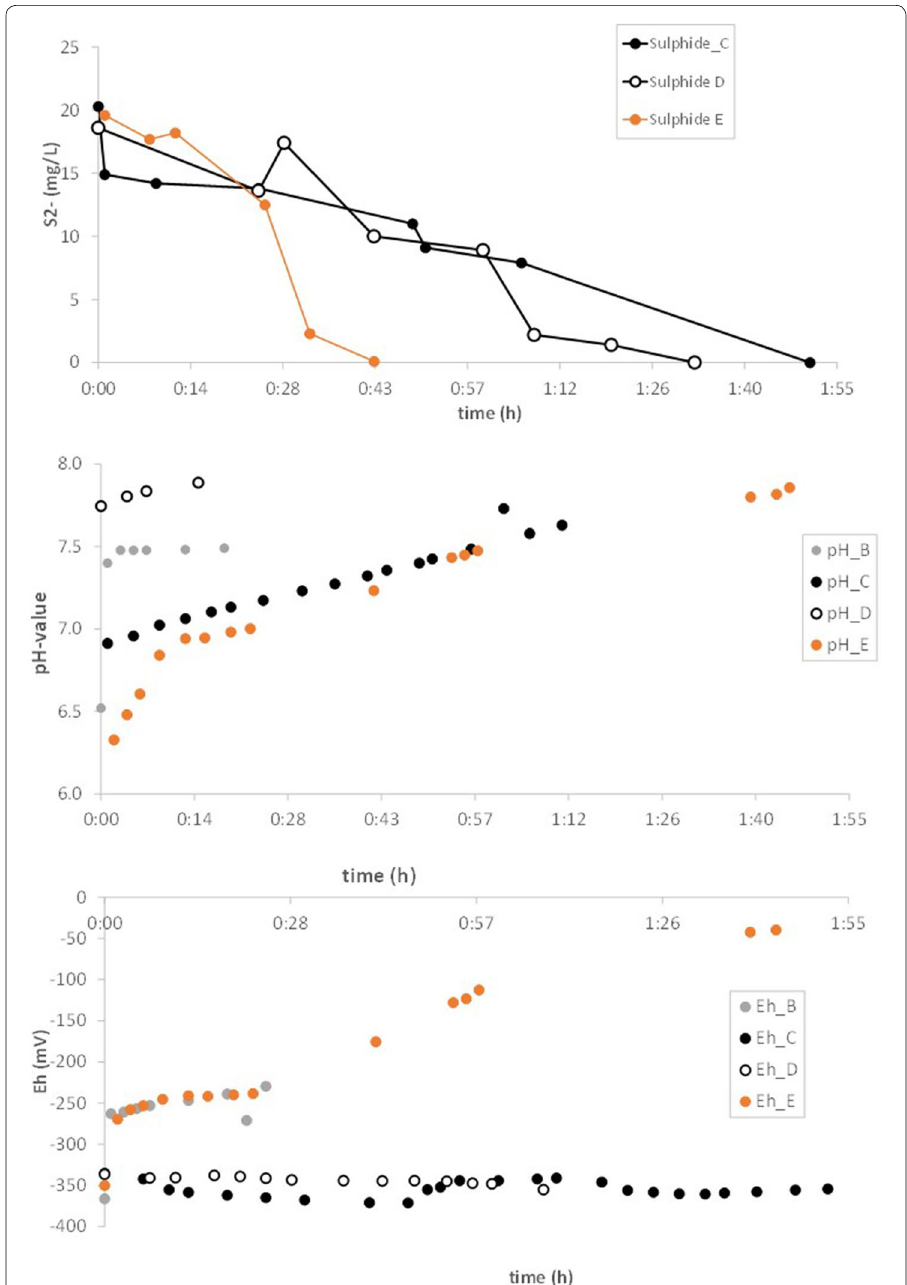
Fig. 6 Concentration of hydrogen sulfide (top), pH value (middle), and redox (bottom) in the reaction container after adding GFH (B, C, D) and FeCl 3 (E: orange dots) to the thermal